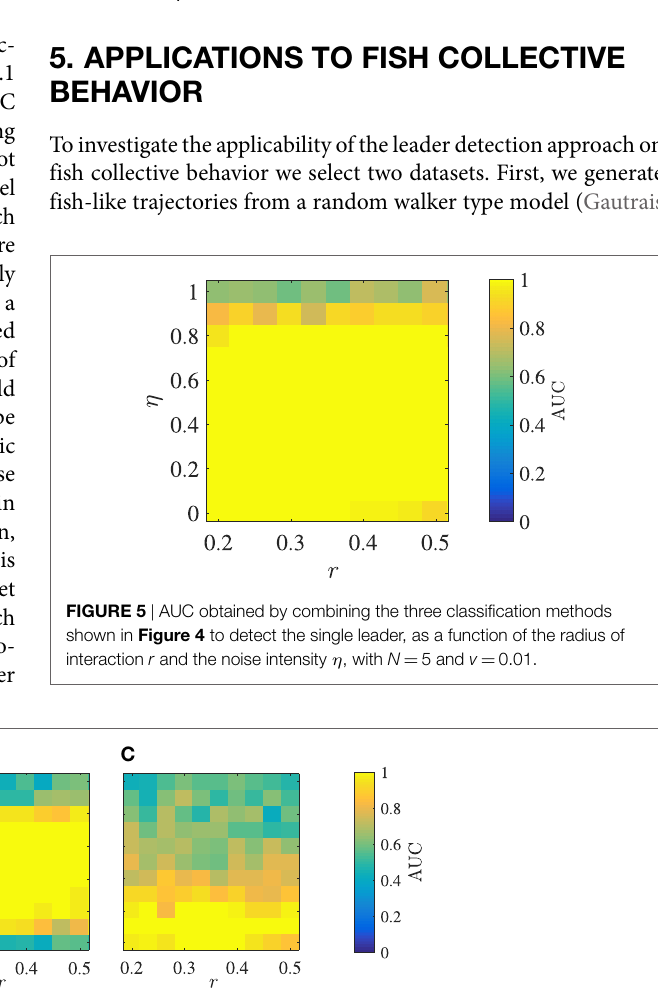
Frontiers in Robotics and AI |